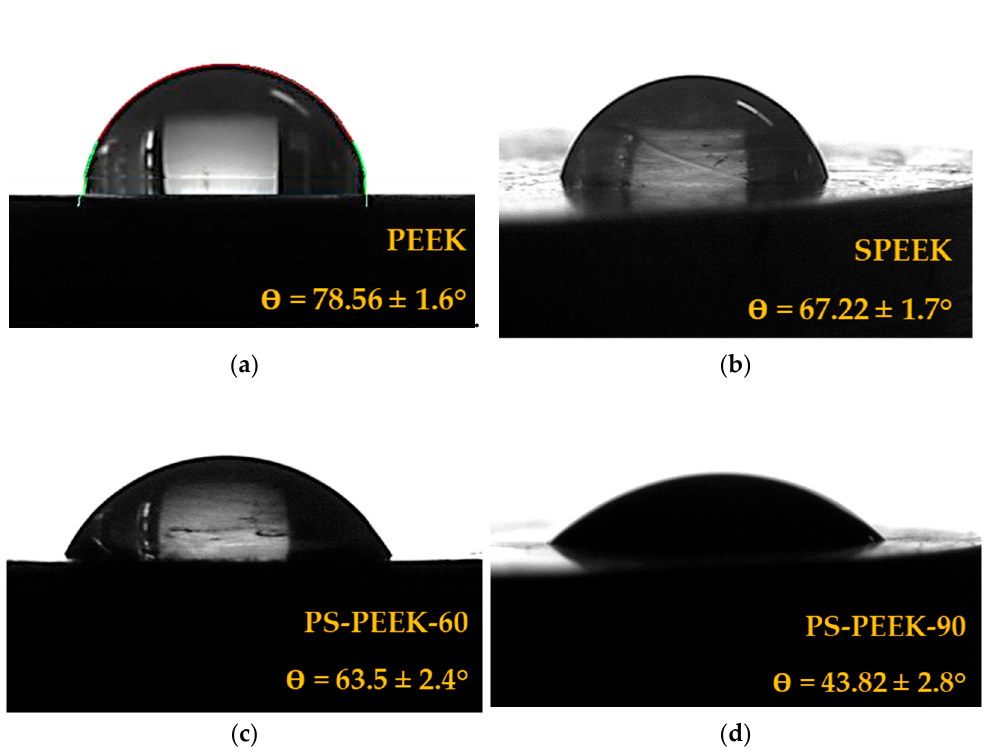
Figure 2. Contact angle of ( a ) PEEK, ( b ) SPEEK, ( c ) PS-PEEK-60 and ( d ) PS-PEEK-90 samples. Introduction of a hydrophilic HSO 3 functional group on SPEEK and PS-PEEK sur- faces, confirmed by FTIR analysis, has noticeably reduced the contact angle when com- pared to that of PEEK. Furthermore, an increase in immersion time in piranha solution